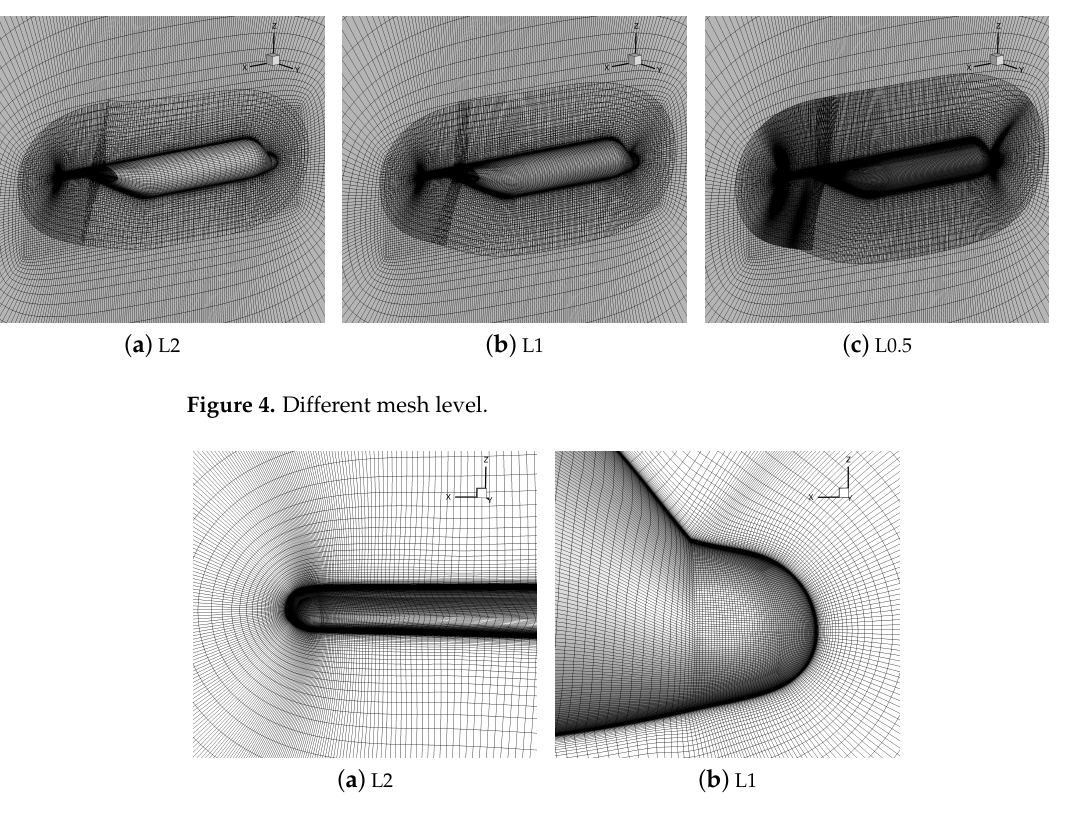
Figure 5. Zoomed figure of the grid around the wall of afterbody and nose. Table 2. Mesh convergence